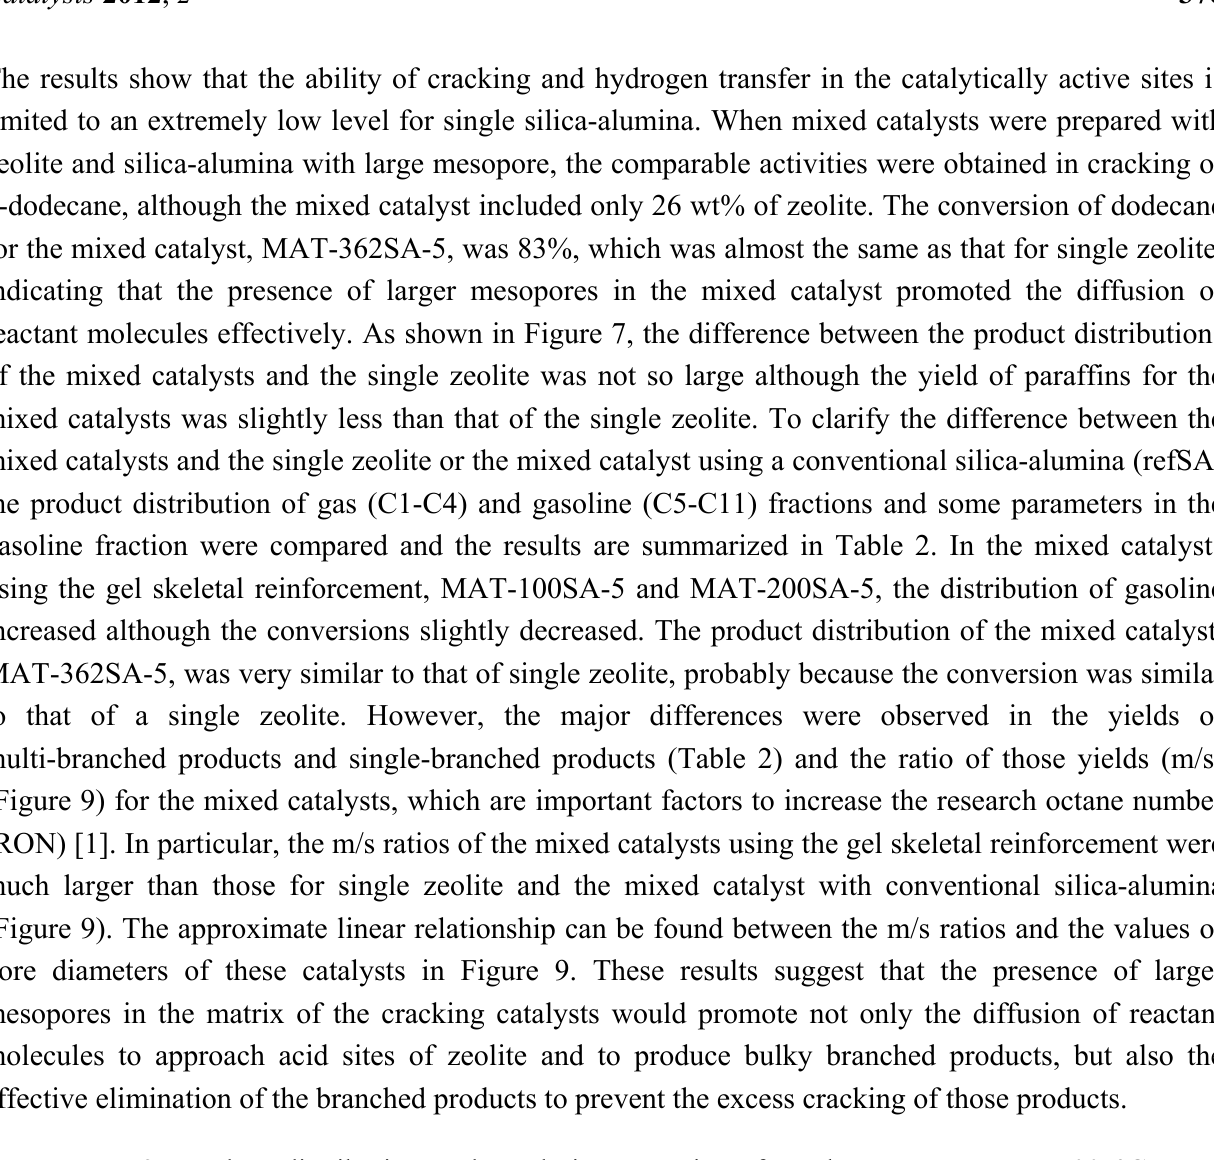
Table 2. Product distribution and catalytic properties of catalyst. Temperature 500